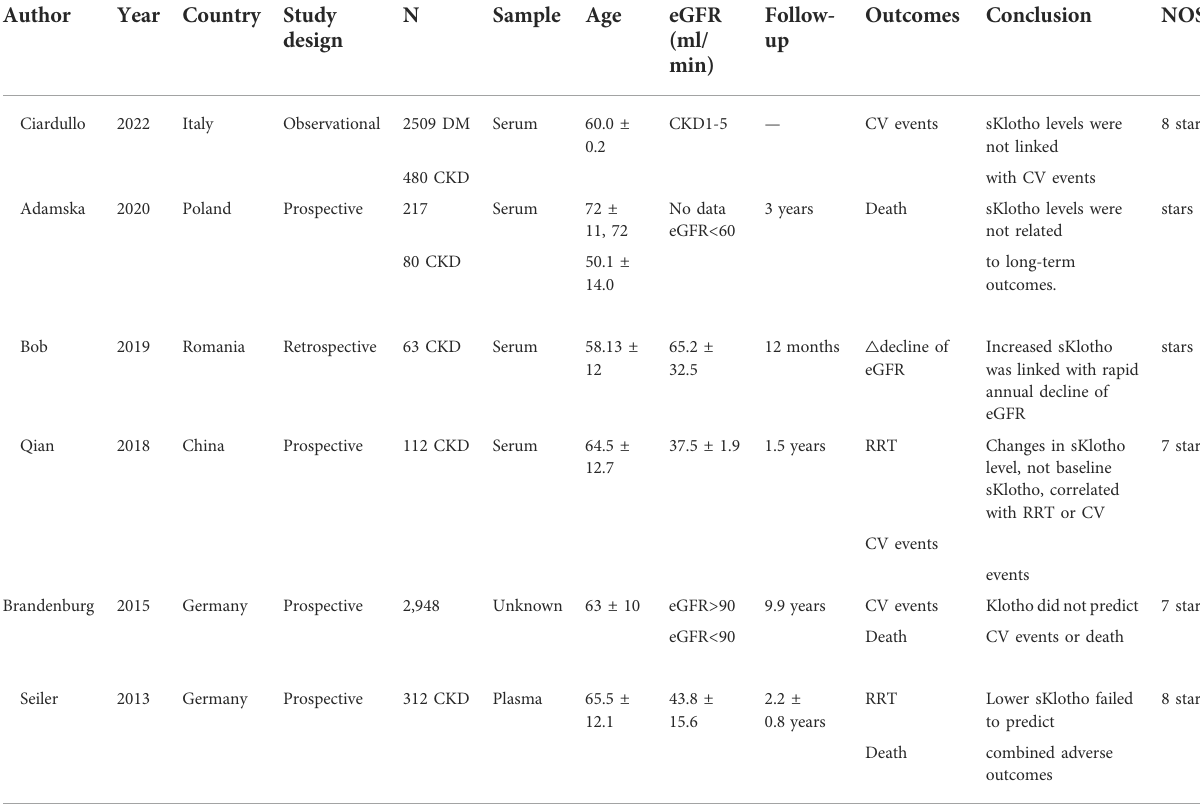
TABLE 2 Characteristics of the negative studies regarding the relationship of Klotho with adverse clinical outcomes (low versus high sKlotho